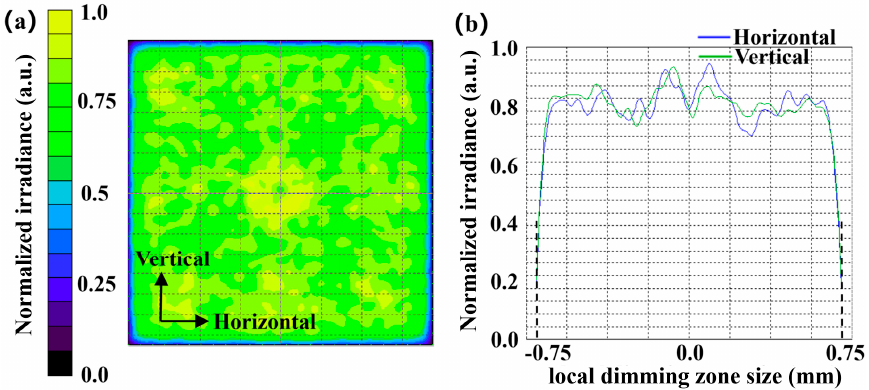
Figure 3. Simulation results of a single local dimming zone: ( a ) 2D irradiance map and ( b ) normalized irradiance distribution curves in the horizontal and vertical direction.